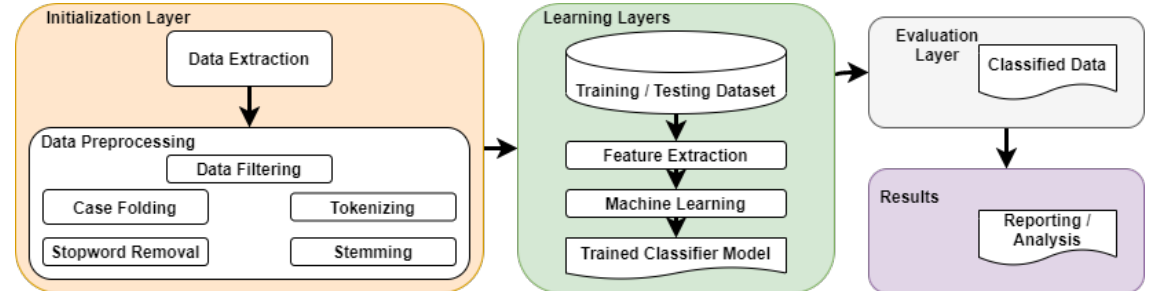
Figure 1. Block diagram of the Proposed